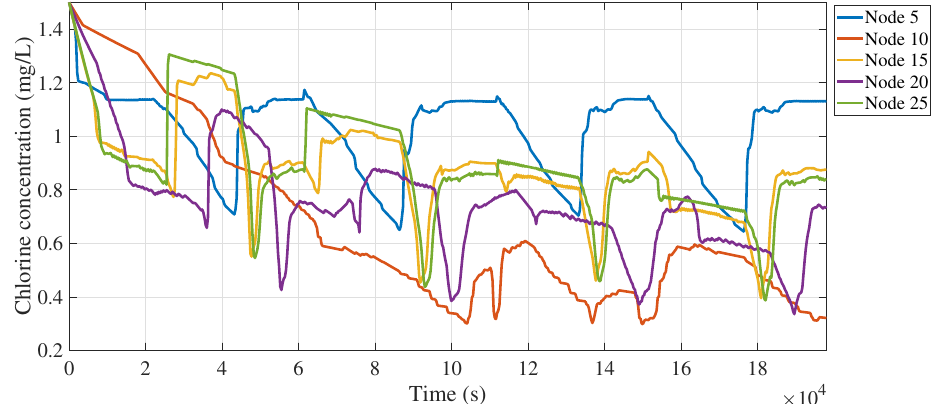
Figure 13. Evolution of measured chlorine concentration with s Q = 1.271229 mg/L and i Q = is 1.5 mg/L. Discussion of the Results